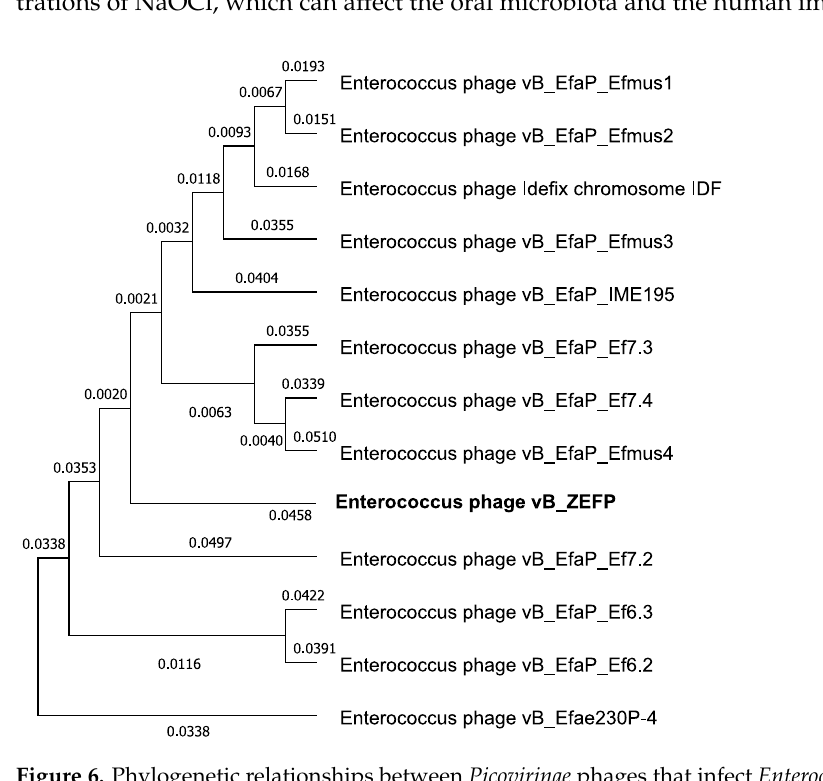
of the groupings.